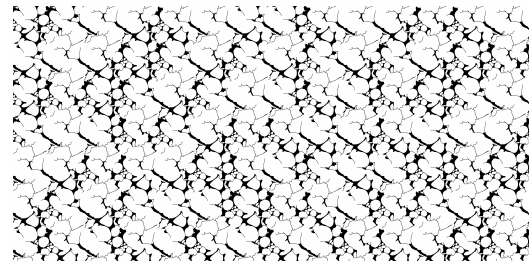
Figure 10. Synthesized domain utilizing the modified CSHD algorithm and tiles from Fig. 9) with underlying tiling map from Table 3.